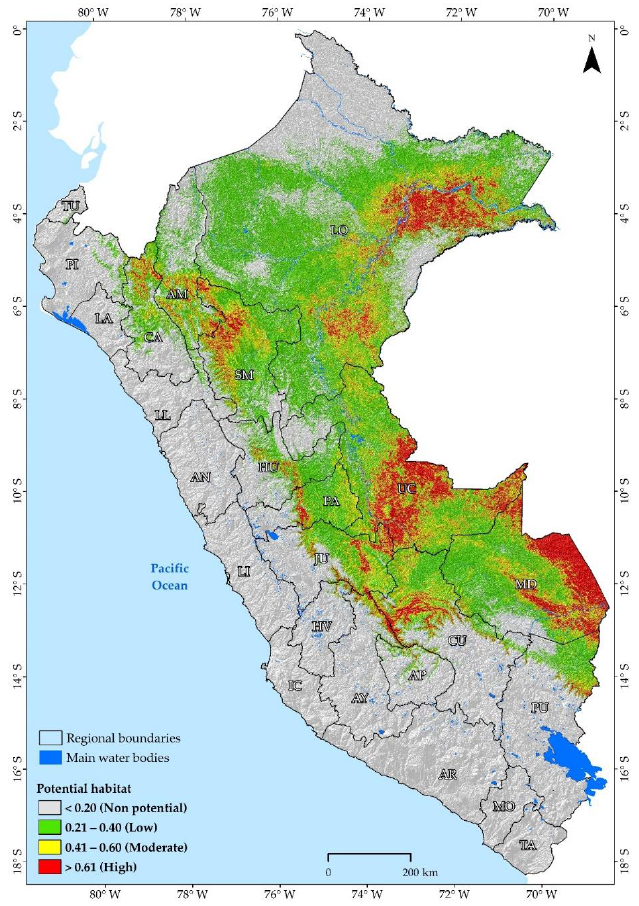
Figure 4. Distribution of the biographical model of the genus Cedrela in Peru.